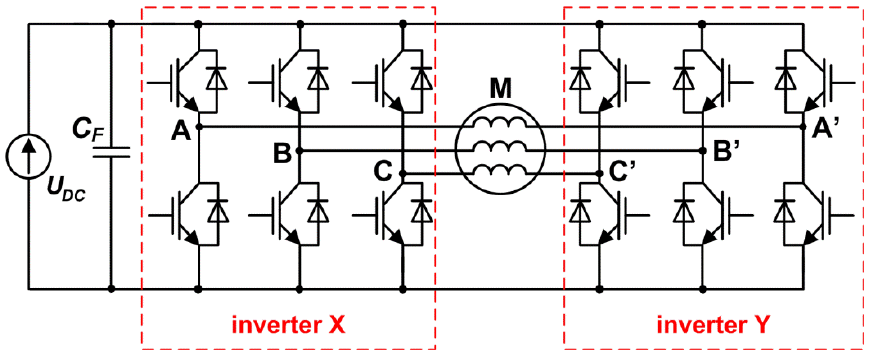
Figure 7. Dual two-level inverter.